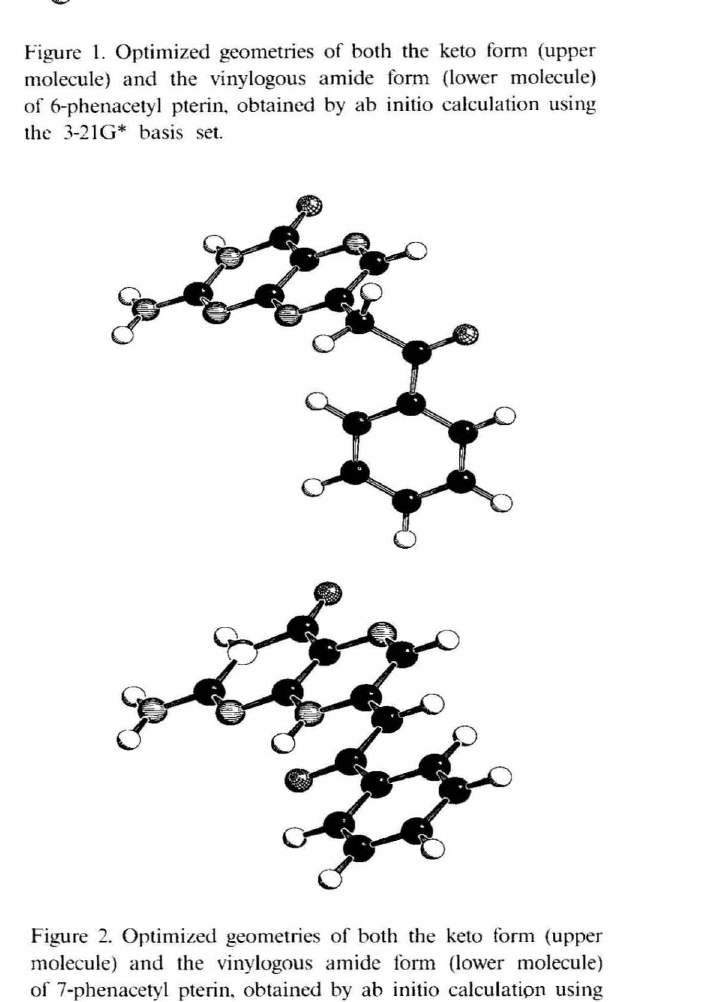
Figure 2. Optimized geometries of both the keto form (upper molecule) and the vinylogous amide form (lower molecule) of 7-phenacetyl pterin, obtained by ab initio calculation using the 3-21 G* basis